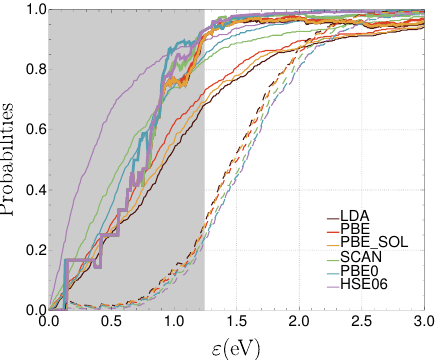
Figure 8. Probabilities : P r ( M , (cid:101) ) for M in the set of 6 methods (thin curves), P r | s ( M , (cid:101) ) (thick curves), and P s | r ( M , (cid:101) ) (dashed curves). The gray rectangle covers the region where the selected sample size is less than 100.